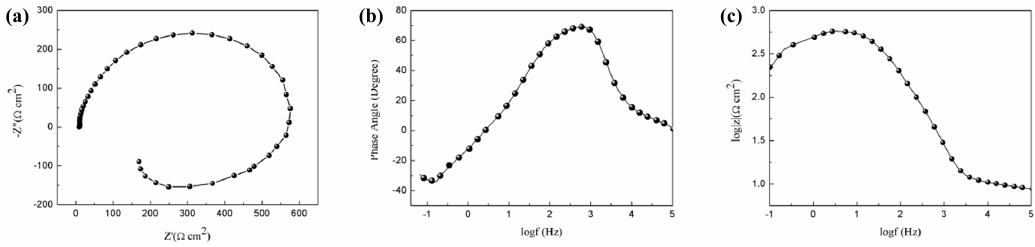
Figure 6. ( a ) Nyquist plot, ( b ) Bode plot of impedance vs. frequency, ( c ) Bode plot of phase angle vs. frequency of the extruded alloy.